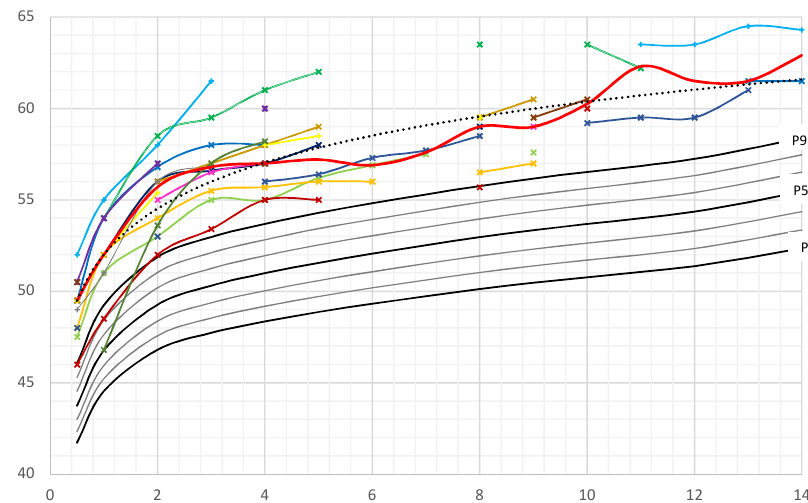
Figure 1. Head circumference (HC) of male PTEN hamartoma tumor syndrome (PHTS) patients in comparison to German reference growth charts [11]. Legend: ___ (red): Median, ……: Trendline, ___: P3-P97. Colored lines: individual patient’s HC curves.